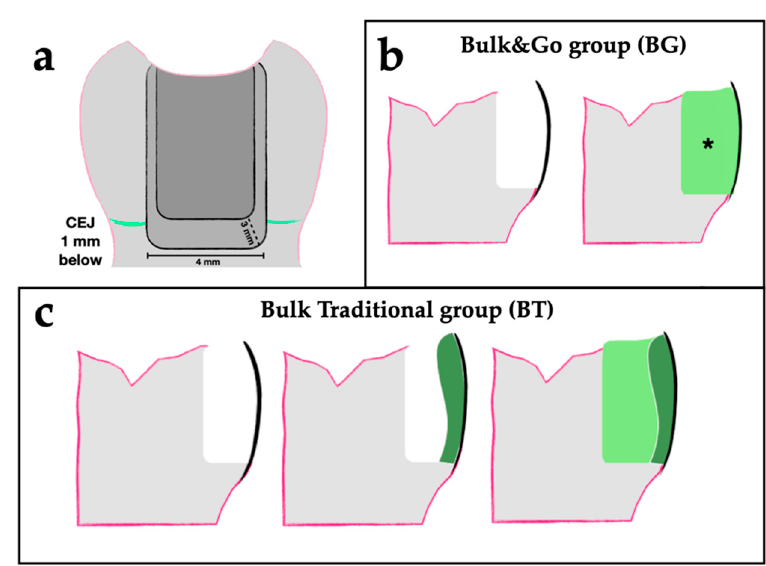
Figure 1. Cavity design and samples preparation. Panel ( a ) represents the stylized cavity preparation of the samples from the mesial view. Panel ( b ) shows the Bulk&Go filling technique: After cavity preparation and automatrix application, only one single increment of BFC was set directly into the cavity, without performing the proximal wall (asterisk). Panel ( c ) displays the Bulk Traditional filling technique: After cavity preparation and automatrix application, the proximal wall was firstly restored, using a bulk-fill composites (BFC), transforming class II into class I (dark green), then the residual cavity was filled using one single increment of BFC (light green).